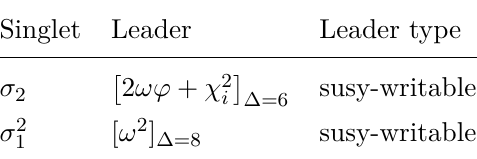
Table 2 . Scalar leaders with N φ = 2 , N der = 0 in d = 8